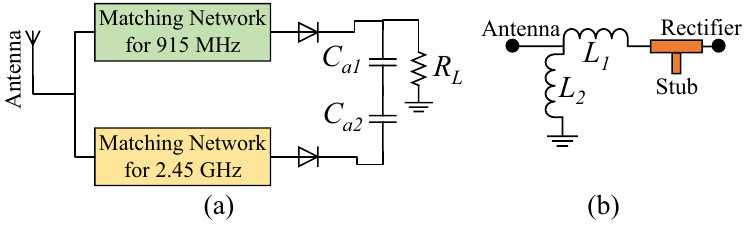
Figure 2. Dual-band rectifier ( a ) proposed topology ( C a 1 = C a 2 18 pF and R L = 10 K (cid:31) ), and ( b )